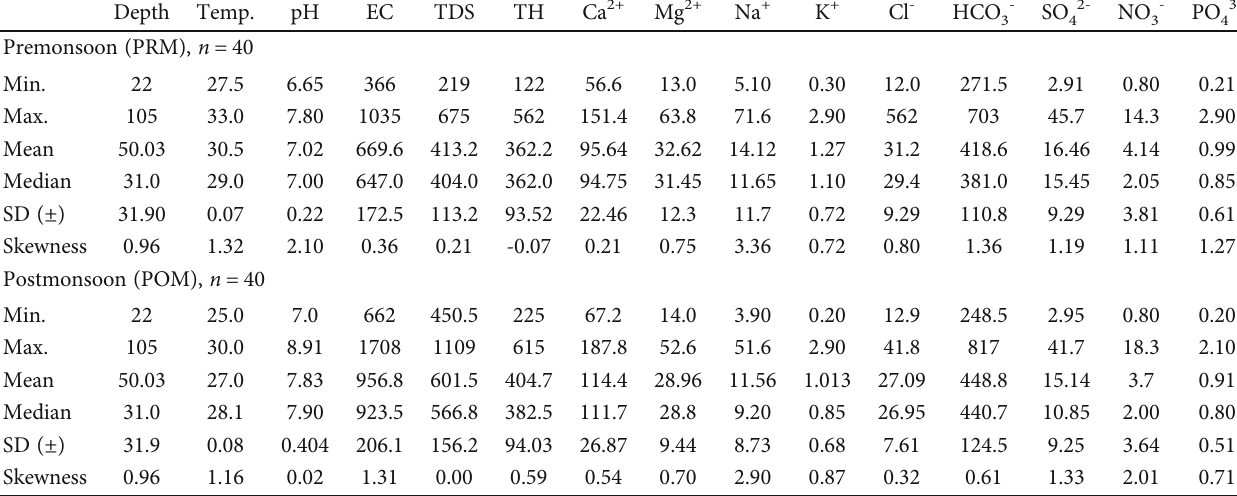
Table 2: Summary of the analyzed data of the groundwater in the premonsoon (PRM) and postmonsoon (POM) of the 2020 sampling campaign, with basic